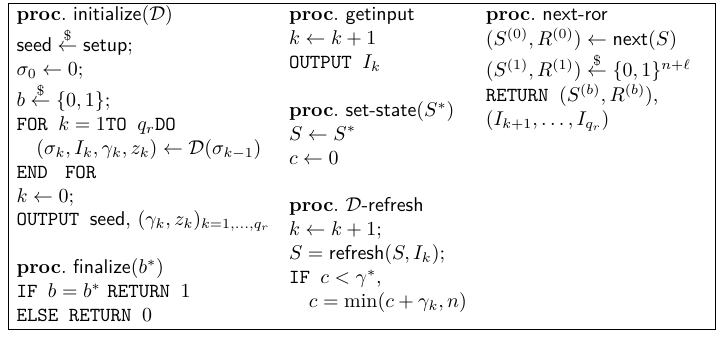
Figure 28: Procedures in Security Game RECOV ( q r , γ ∗